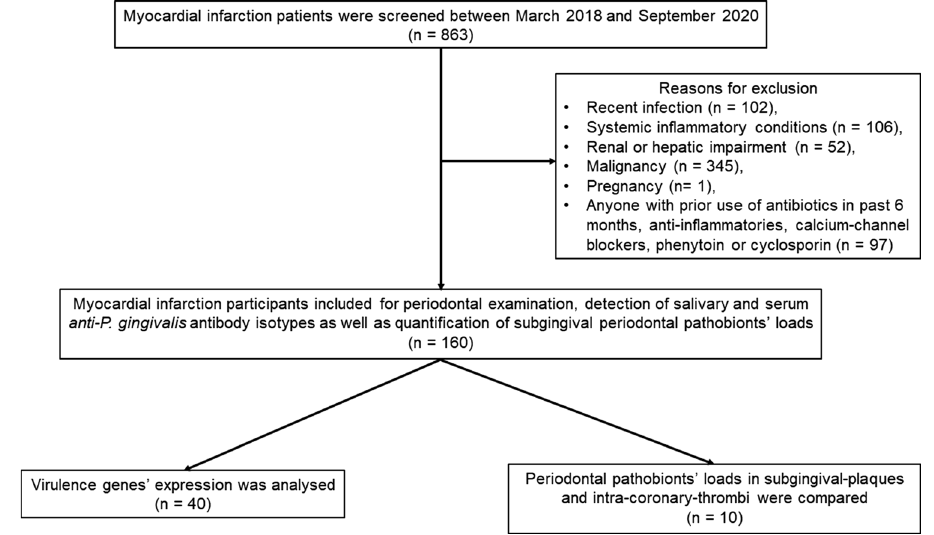
Figure 3. Study flow-chart (STROBE-type